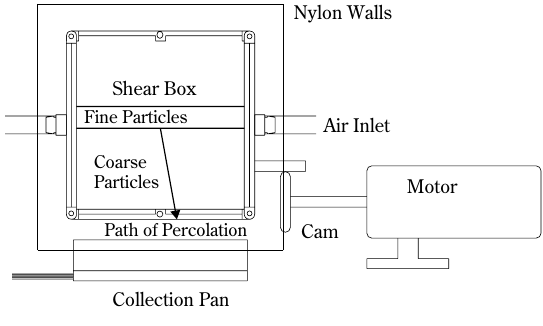
Fig. 2 Overall schematic of primary segregation shear cell